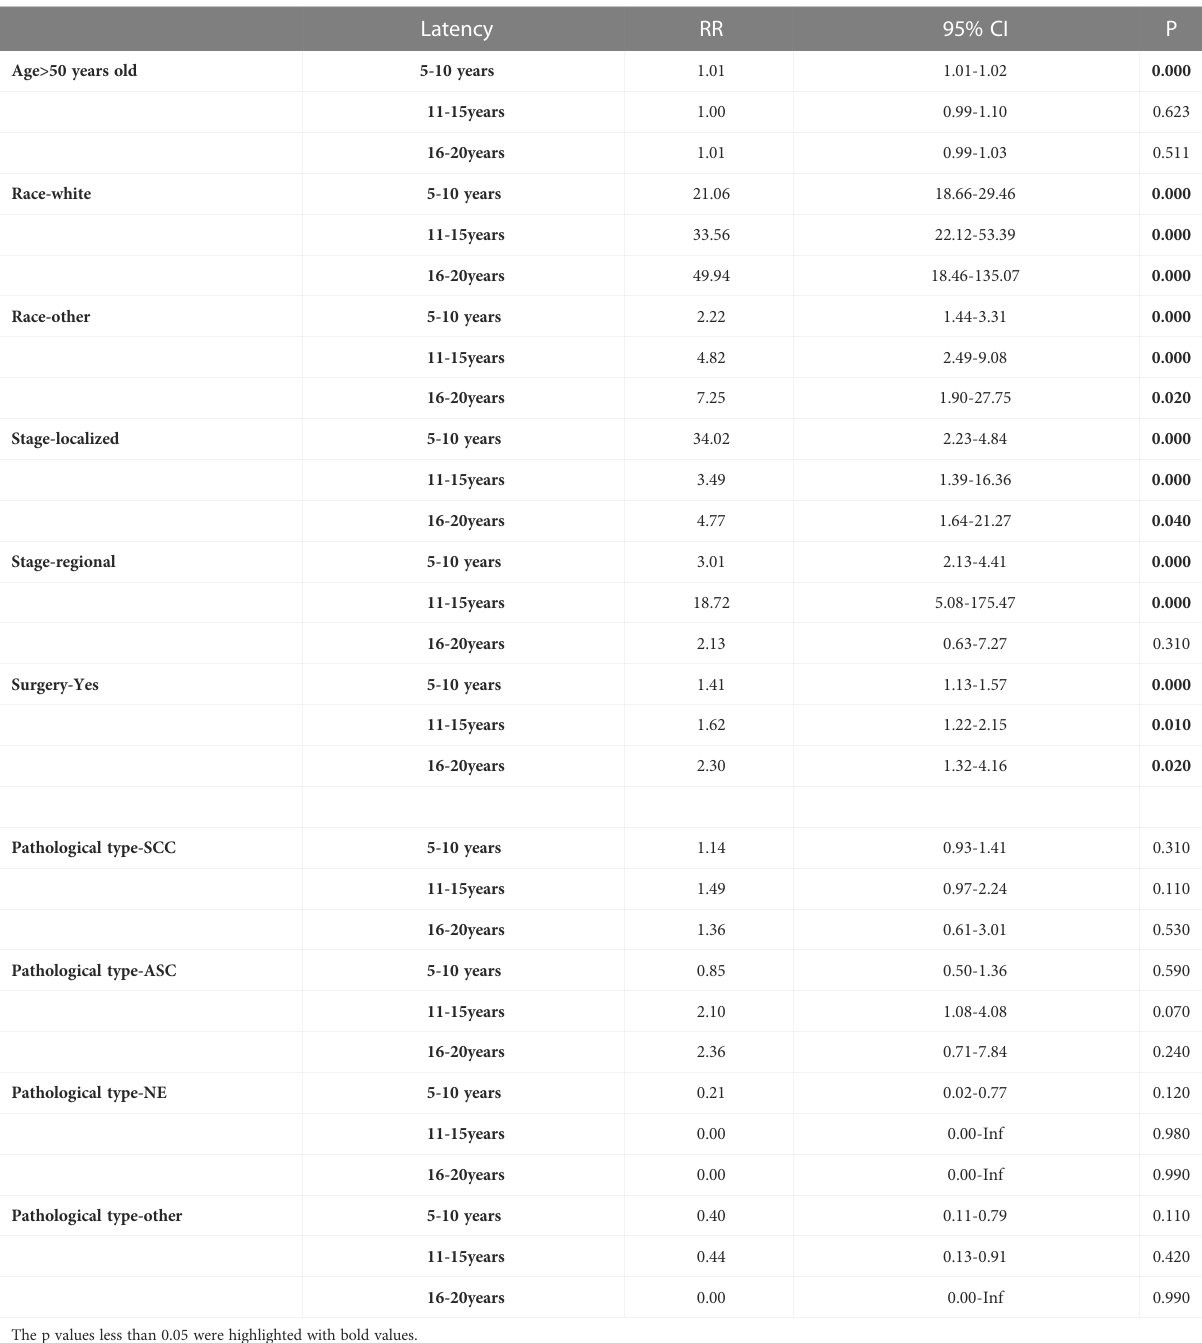
TABLE 2 The dynamic risk in different period